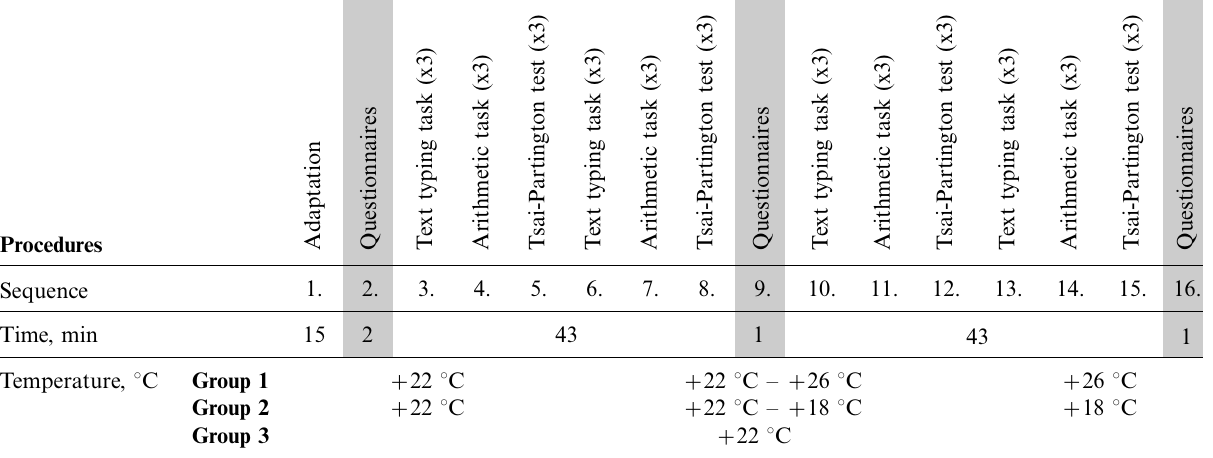
Table 2. Timetable of the implementation of the experiment